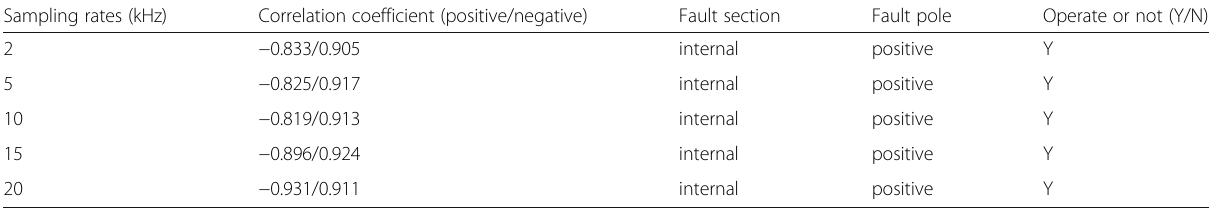
Table 4 Protection results with different sampling rates Sampling rates